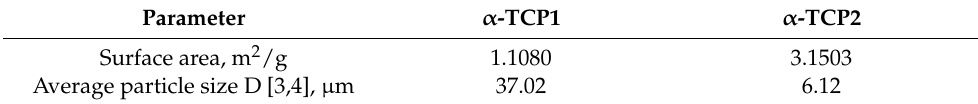
Table 1. Surface area and average particle size of α -TCP under different grinding